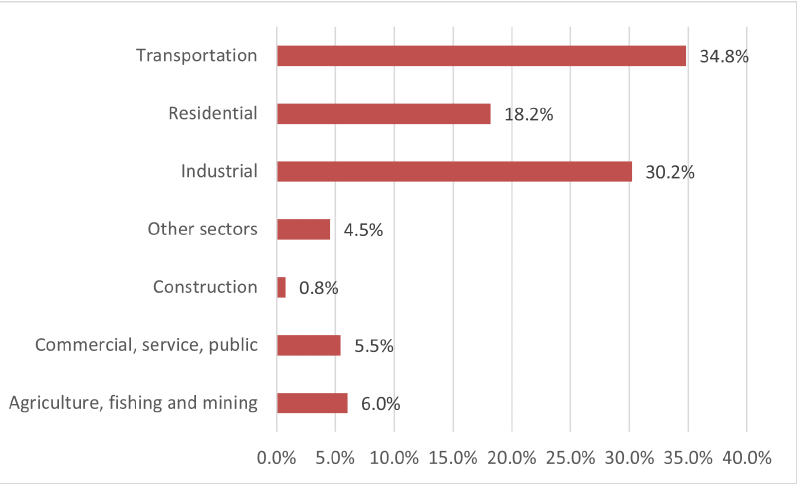
Figure 3. Share by sector of final energy consumption in Latin America and the Caribbean for the year 2020. Adapted from